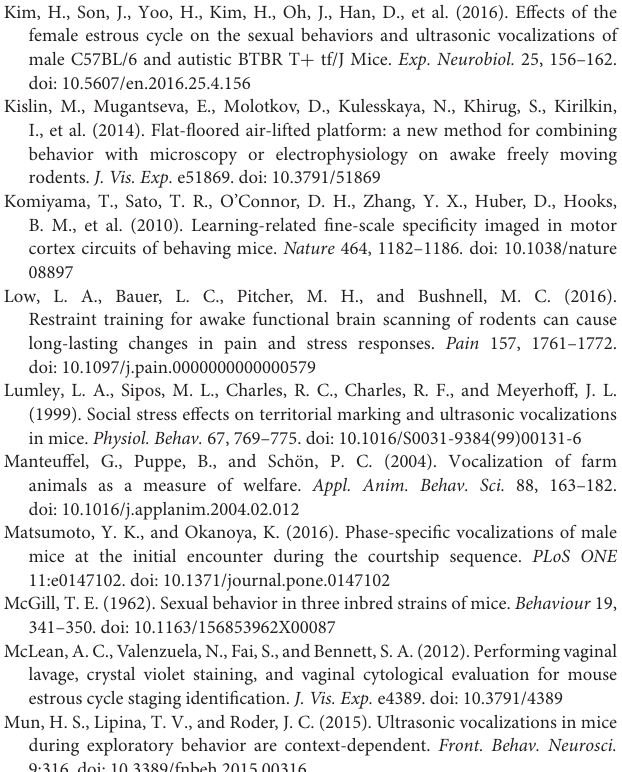
9:316. doi: 10.3389/fnbeh.2015.00316 Neunuebel, J. P., Taylor, A. L., Arthur, B. J., and Egnor, S. E. (2015). Female